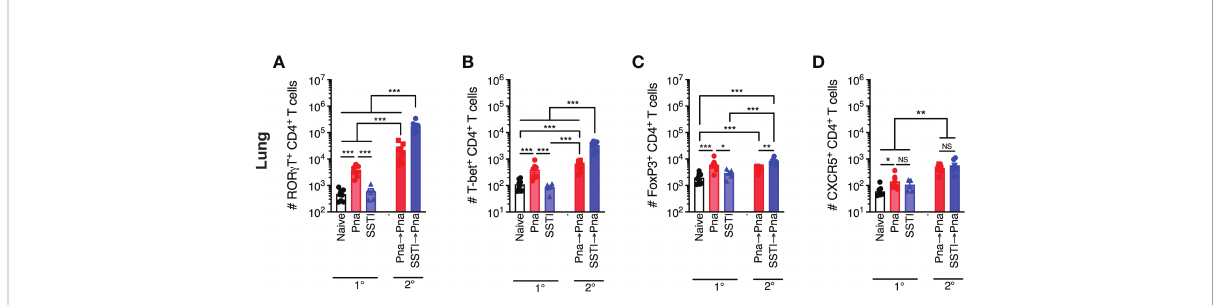
FIGURE 4 T cell responses in the lung following S. aureus pneumonia and SSTI. Using the model depicted in Figure 3A, CD4 + T cell subsets were quanti fi ed in the lungs 7 days following primary SSTI or pneumonia (Pna) or secondary pneumonia following SSTI (SSTI ! pna) or pneumonia (pna ! pna). There were higher numbers of ROR g t + (A) , T-bet + (B) , FoxP3 + (C) , and CXCR5 + (D) CD4 + T cells in the lungs of mice that received pneumonia, compared with naïve or SSTI groups. Mice that were primed with SSTI prior to secondary pneumonia (SSTI ! Pna) had higher numbers of ROR g t + (A) , T-bet + (B) , and FoxP3 + (C) CD4 + T cells in the lungs, compared with mice that received primary pneumonia (Pna) or mice that received secondary pneumonia following priming with primary pneumonia (Pna ! Pna). Mice that were primed with SSTI (SSTI ! Pna) or pneumonia (Pna ! Pna) prior to secondary pneumonia had increased numbers of CXCR5 + CD4 + T cells, compared with naïve mice or mice that received primary pneumonia (Pna ! Pna) (D) . N=5-8 mice/group pooled from 2 independent experiments. All data are presented as mean ± SEM. Data were compared using one-way ANOVA on log 10 -transformed values with Tukey ’ s post-test. * indicates p <0.05, ** indicates p <0.01, *** p <0.001. NS means not signi fi